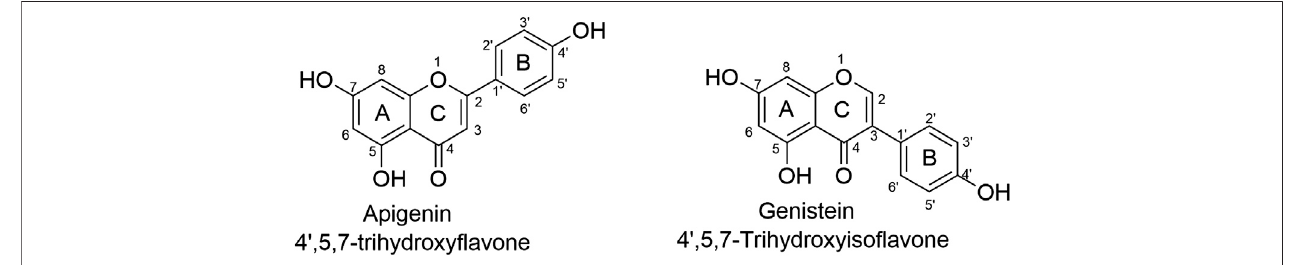
FIGURE1| Thechemicalstructuresofisomersapigeninandgenistein.Apigeninandgenisteinsharethesameformulatebutstructurallydifferatthelinkingposition of ring B and C. Such minor difference has led to signi fi cant different pharmacological pro fi les.